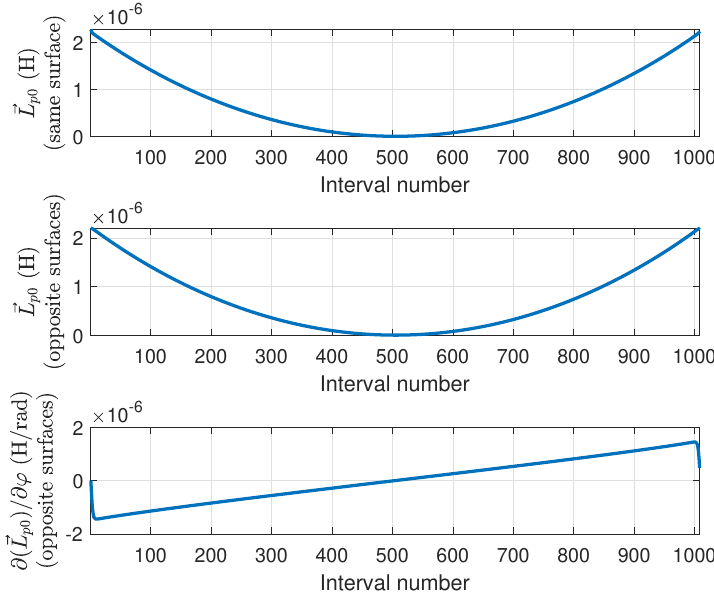
Figure 11. Partial inductance between two conductors of the simulated machine (32), if the conductors are in the same surface ( top ), or in opposite surfaces ( middle ). Derivative of the partial inductance with the angle (35), when the conductors are in opposite surfaces ( bottom ).